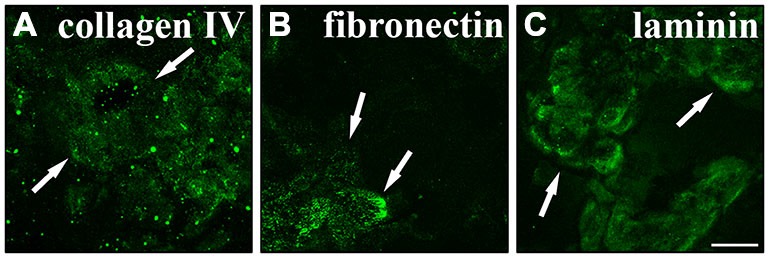
Secretion of normal Bruch’s membrane components by RPE cells. RPE cells (15,000 cells/cm2) cultured for 2 weeks were seeded on poly-D-lysine (PDL)-coated coverslips overnight and lysed the next day using deionized H2O. Using immunostaining the underlying matrix was visualized. RPE cells expressed and secreted collagen IV (A), fibronectin (B) and laminin (C). White arrows are pointing at sites of strong immunoreactivity. Scale bar = 50 μm.